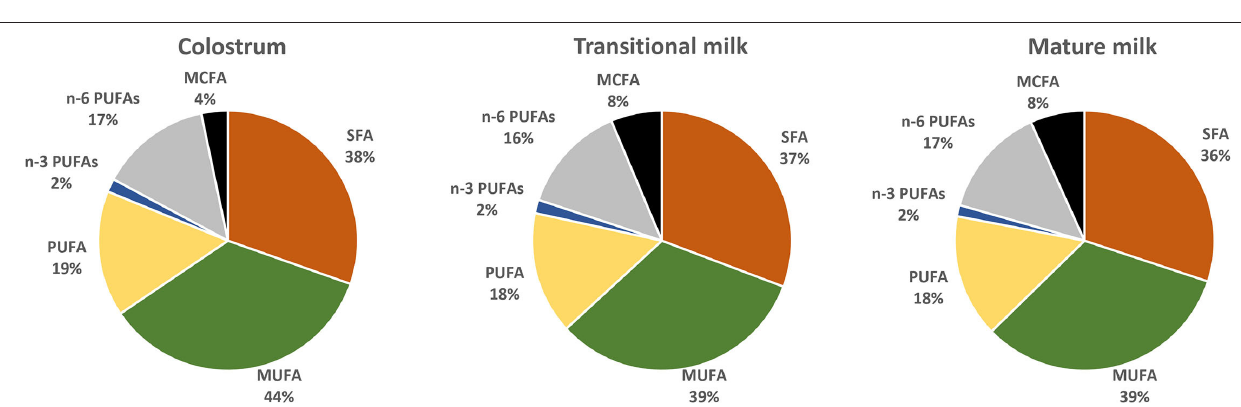
FIGURE 6 | Distribution of phospholipids fatty acids categories in colostrum (1–7 days), transitional milk (8–15 days) and mature milk (60 days) from Chinese mothers reported by Wei et al. (82). PUFAs, polyunsaturated fatty acids; n-3 PUFAs, n-3 polyunsaturated fatty acids; n-6 PUFAs, n-6 polyunsaturated fatty acids; MUFA, monounsaturated fatty acids; SFA, saturated fatty